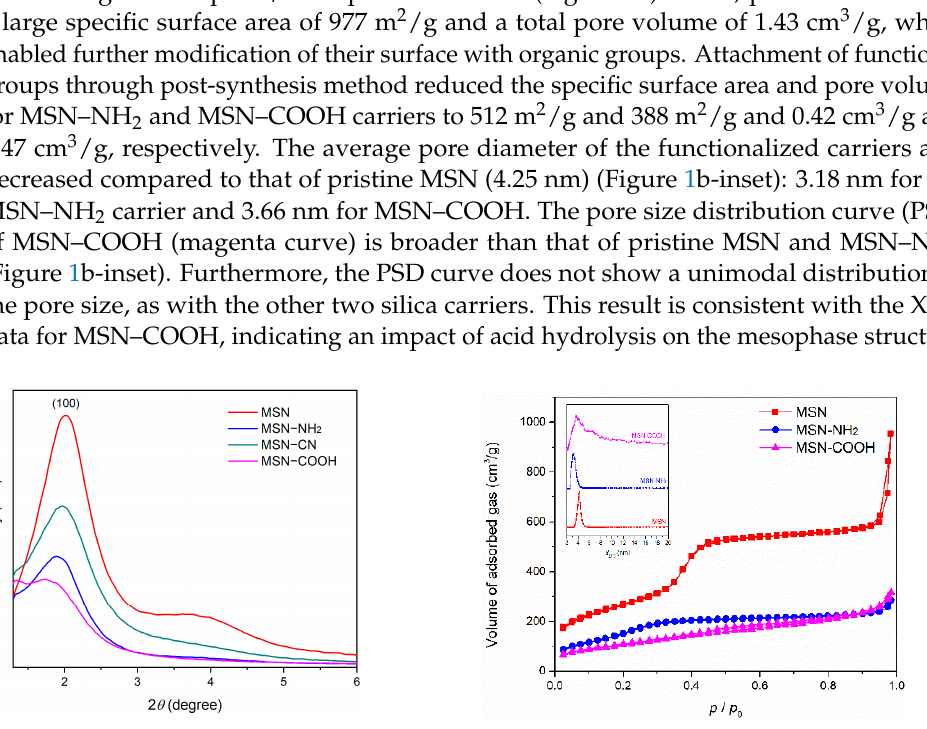
Figure 2. Thermogravimetric analysis of MSN carriers and polyphenolic-extract-loaded MSN. Table 1. Textural parameters of MSN carriers. Sample